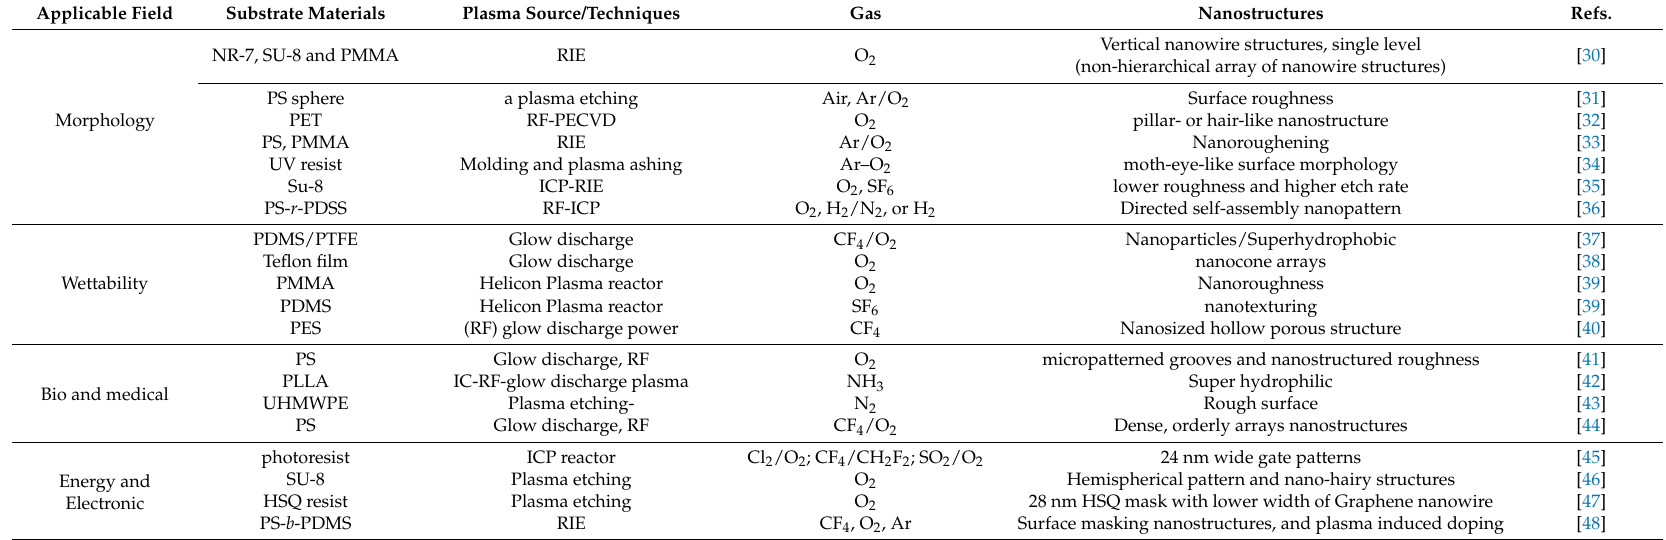
Table 1. Plasma nanostructuring on polymer